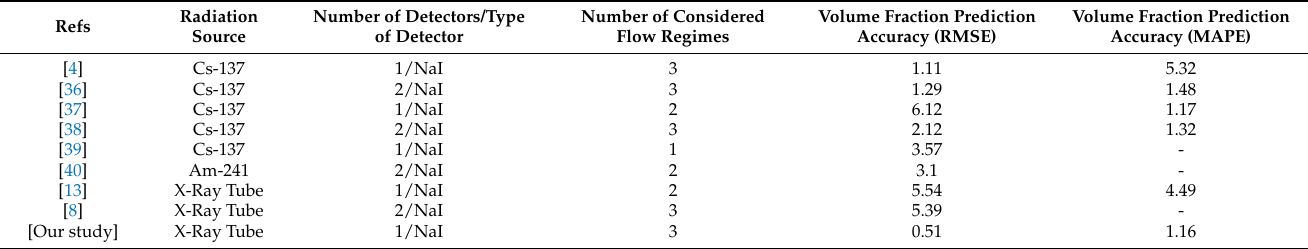
Table 4. The results of the relevant investigations and the presented two-phase flow meter in this